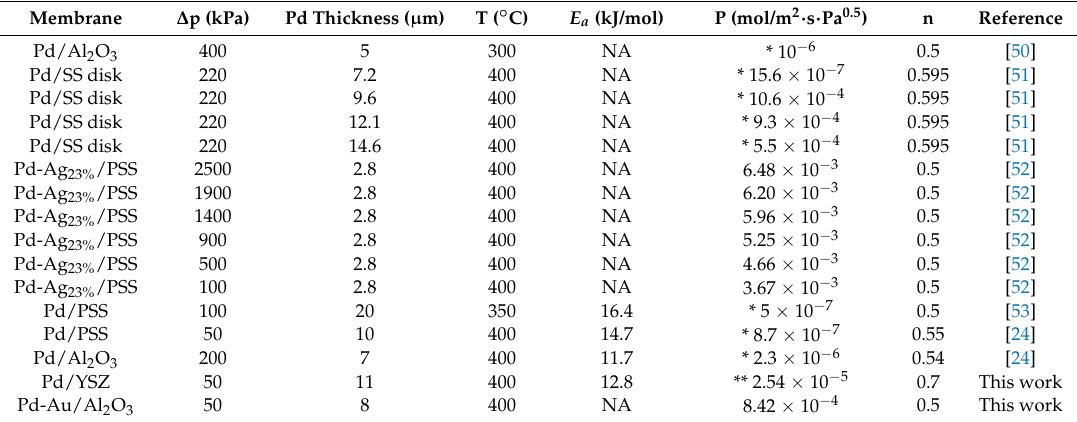
Table 2. Gas mixtures fed into the Pd and Pd-Au MRs at 400 °C for permeation tests.